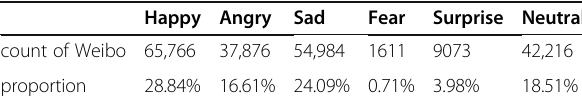
Table 2 Results of emotion classification Happy Angry Sad